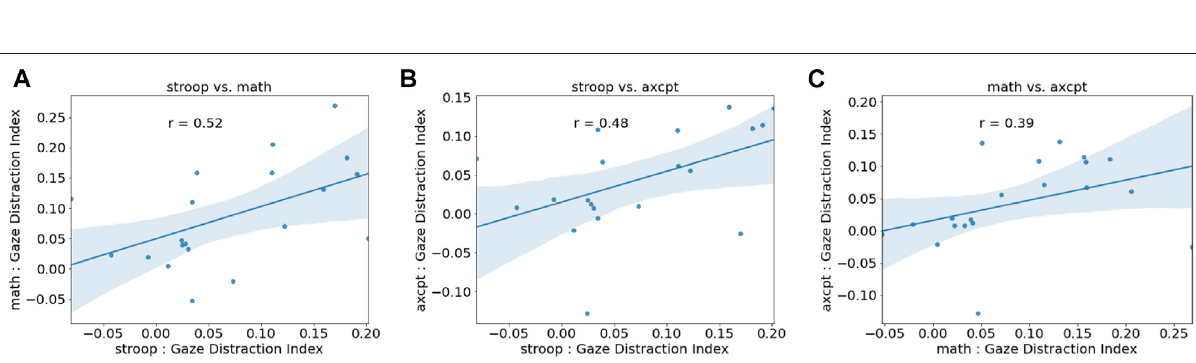
Frontiers in Virtual Reality |